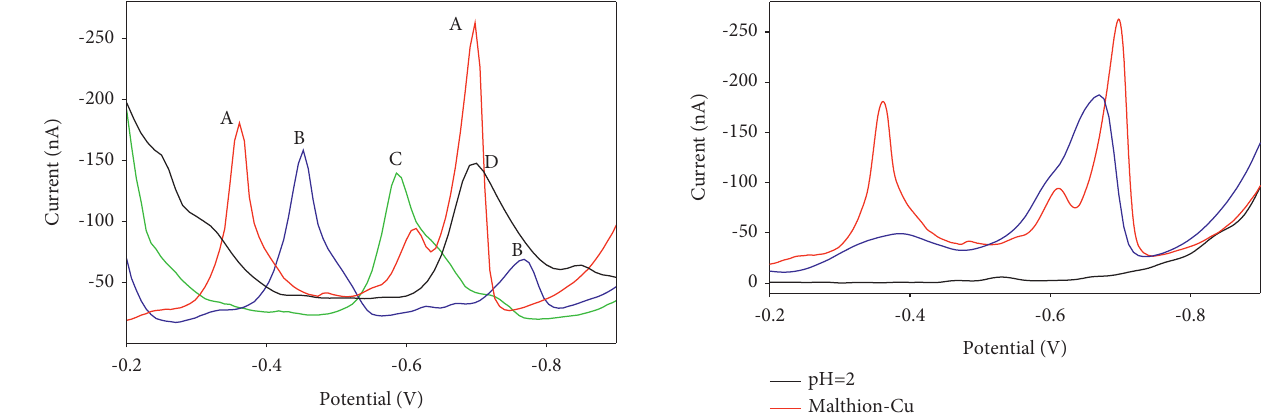
Figure 1: SW-CSV of malathion in the presence of Cu 2+ at pH 2 (a), pH 3 (b), pH 7 (c), and pH 9 (d) at HMDE versus Ag/AgCl electrode.